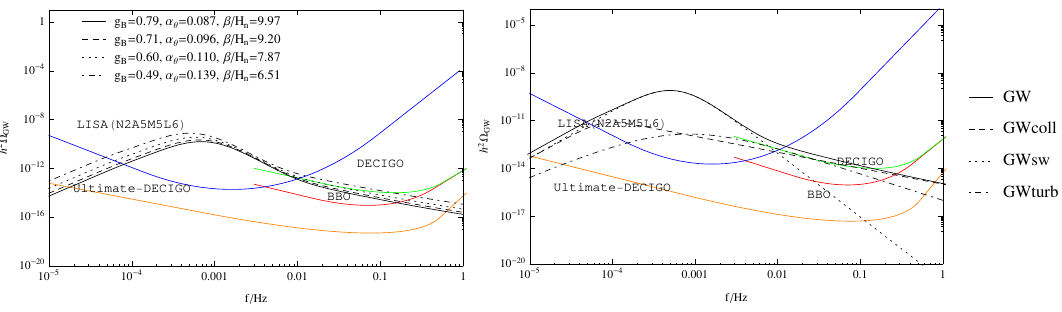
Figure 6 . The contributions of GW spectrum vary with parameters g B in the B-LSSM.